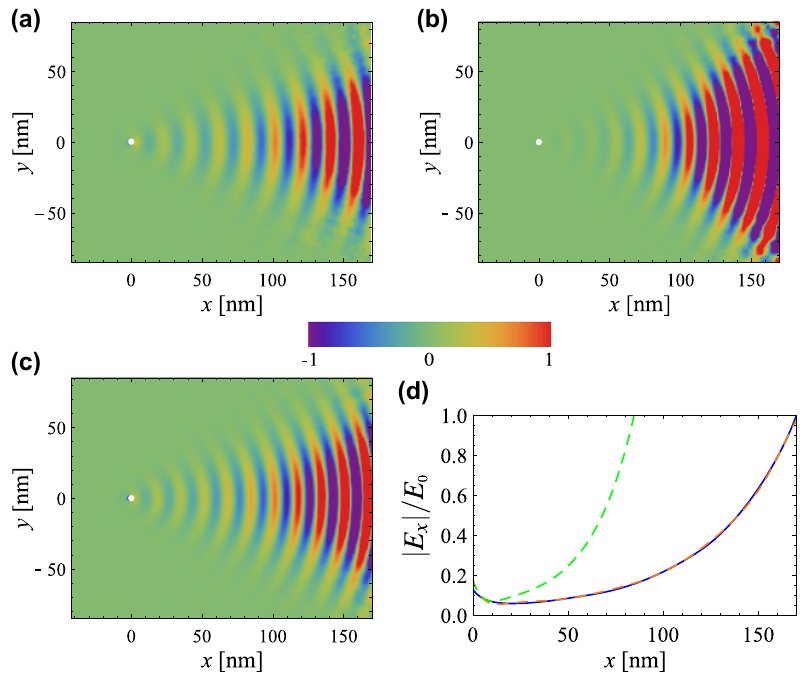
The results obtained with the relativistic Doppler shift theory are shown in Figure 5(b) and (c). Clearly, = 0.6 𝑣 , the relativistic for the same drift velocity 𝑣 0 F model predicts a significantly stronger SPP amplification in a wider angular range than the Galilean model [see Figure 5(a) and (b)], consistent with Figure 4. Interestingly, for the same gain per unit of propagation length, the drift velocity in the relativistic model can be about 14% smaller than in the Galilean model [see Figure 5(c) and (d)].